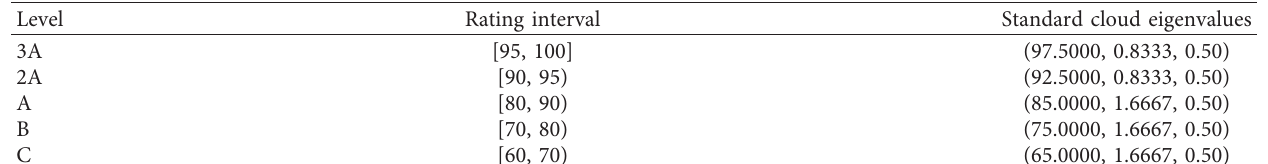
Table 7: Standard cloud eigenvalues of CQMS evaluation.